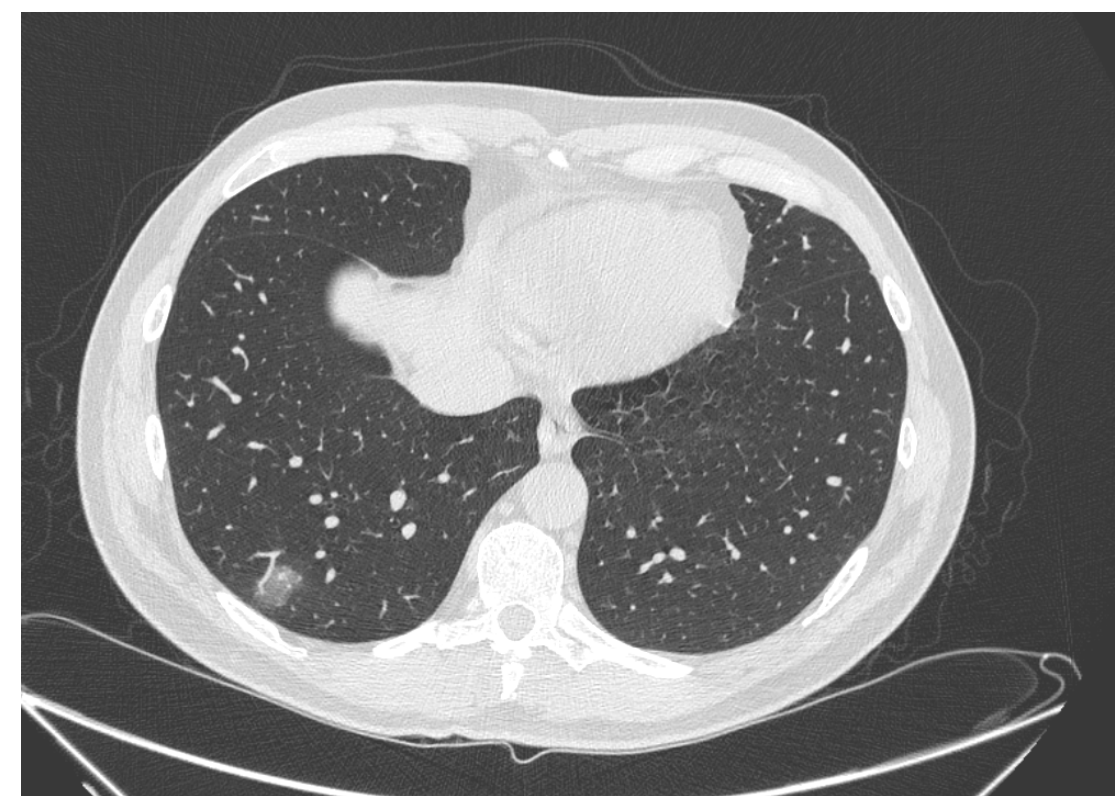
Figure 4. CT examination of a patient with a positive RT-PCR test for COVID-19 infection. The same CT shows a single localization of GGO in the right lower lobe with a rounded morphology.